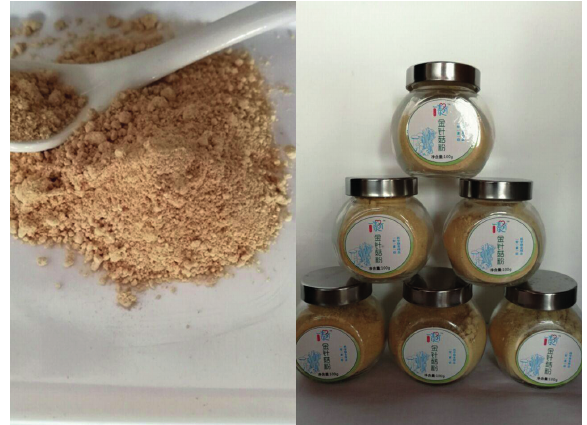
Fig. 2 Flammulina velutipes powders Figure 2: Flammulina velutipes